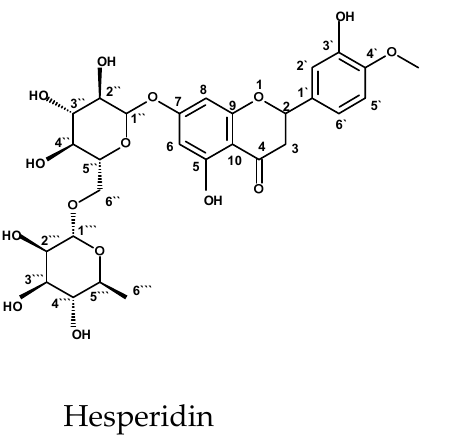
Figure 1. Isolated compounds from C. macrocarpa leaves.